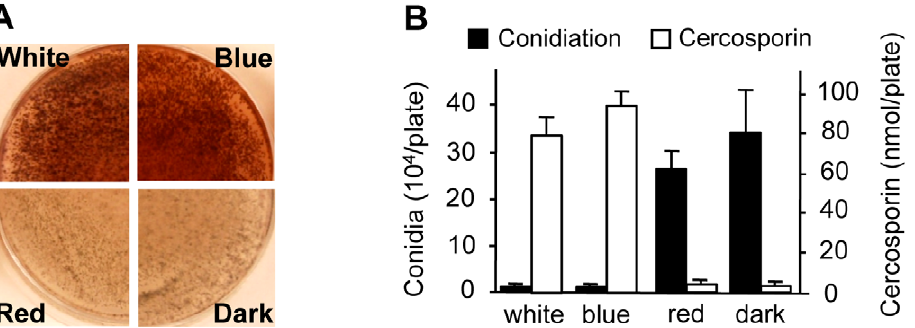
Figure 2. Effects of light on cercosporin biosynthesis and conidiation of C.zeae-maydis . A, Conidia (10 5 ) were spread on 0.2 6 PDA medium, and the plates were incubated for four days in constant white light, blue light (400–530 nm), red light (600–700 nm), or darkness. Cercosporin accumulated in the medium as a dark red pigment. B, Conidiation and cercosporin were measured after four days in cultures grown on V8-agar and 0.2 6 PDA,